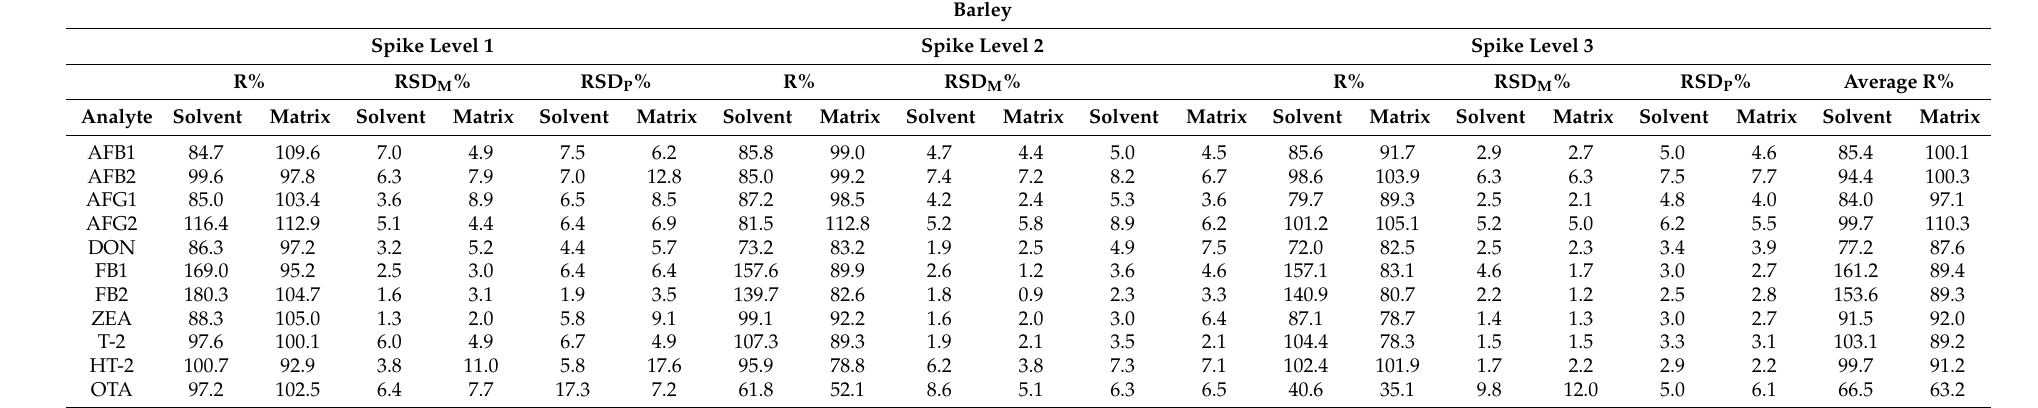
Table 9. Method recovery (R%) and repeatability of measurement (RSD M %) and sample preparation (RSD P %) in barley calculated using solvent and matrix- matched